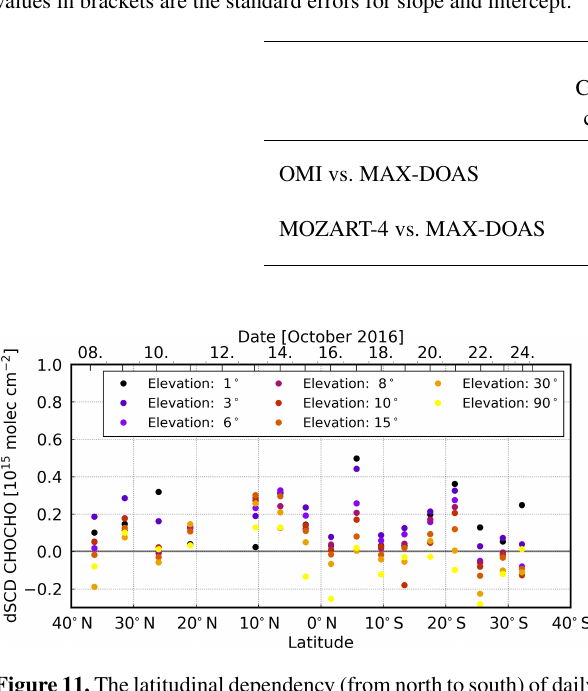
Table 3. Correlation, slope, and intercept between CHOCHO MAX-DOAS and satellite measurements as well as model simulations. The values in brackets are the standard errors for slope and intercept.